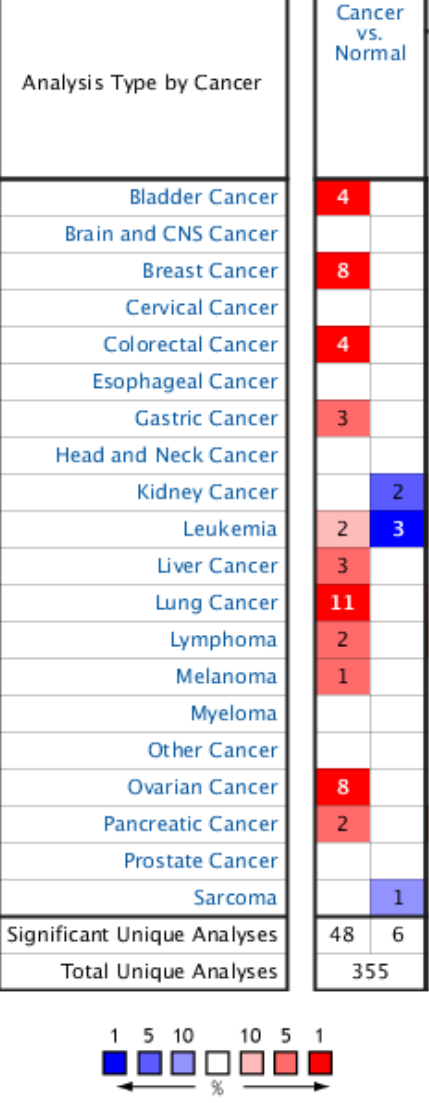
Figure 2. HMGA1 expression levels in different cancer types compared to the corresponding normal tissue: ( A ) TIMER2.0; the statistical significance ( p -value) computed by the Wilcoxon test is anno- tated by the number of stars: * p <0.05; ** p <0.01; *** p <0.001; box plots in grey columns indicate